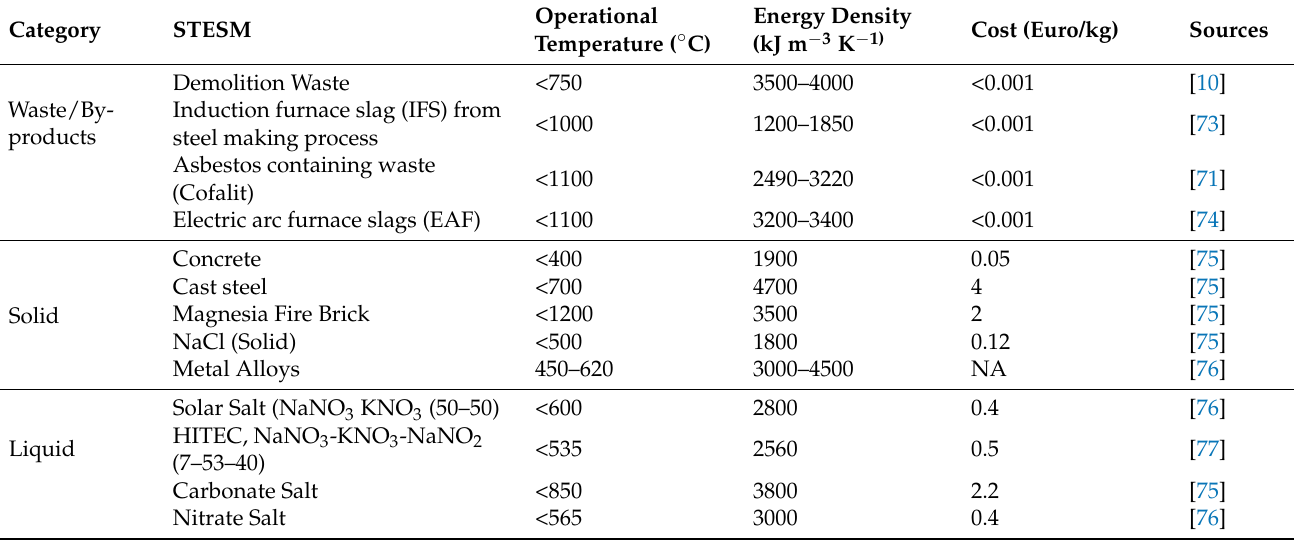
Table 3. Properties of STESMs for high temperature